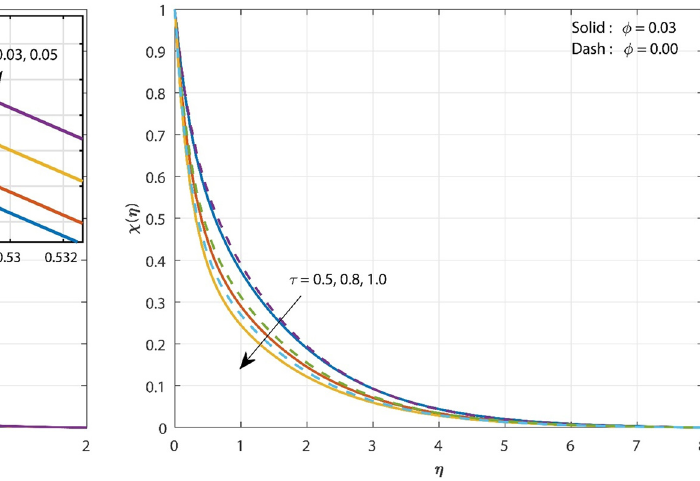
Figure 9: Plot of χ ( η ) over di ff erent values of τ .